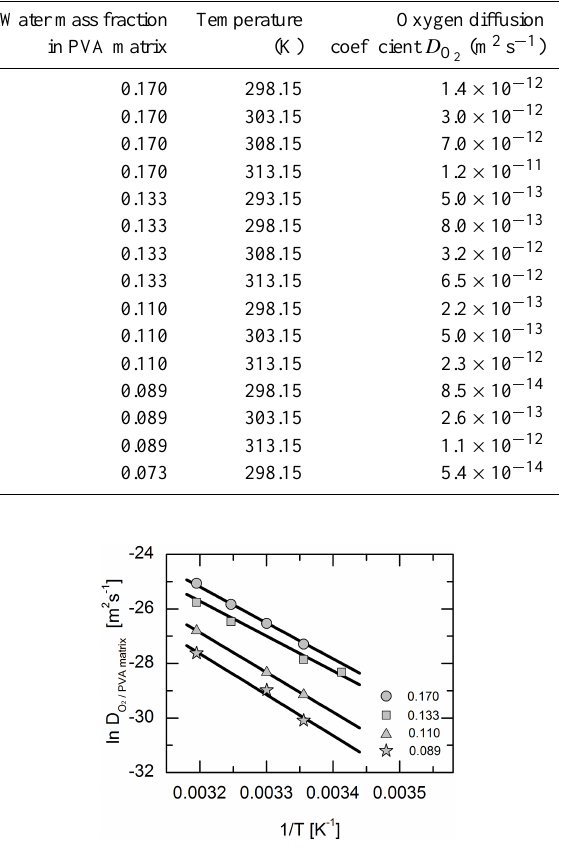
Figure 5. Arrhenius plot of the oxygen diffusion coefficients in the PVA matrix for water mass fractions in the PVA matrix of 0.170, 0.133, 0.110, and 0.089, respectively.